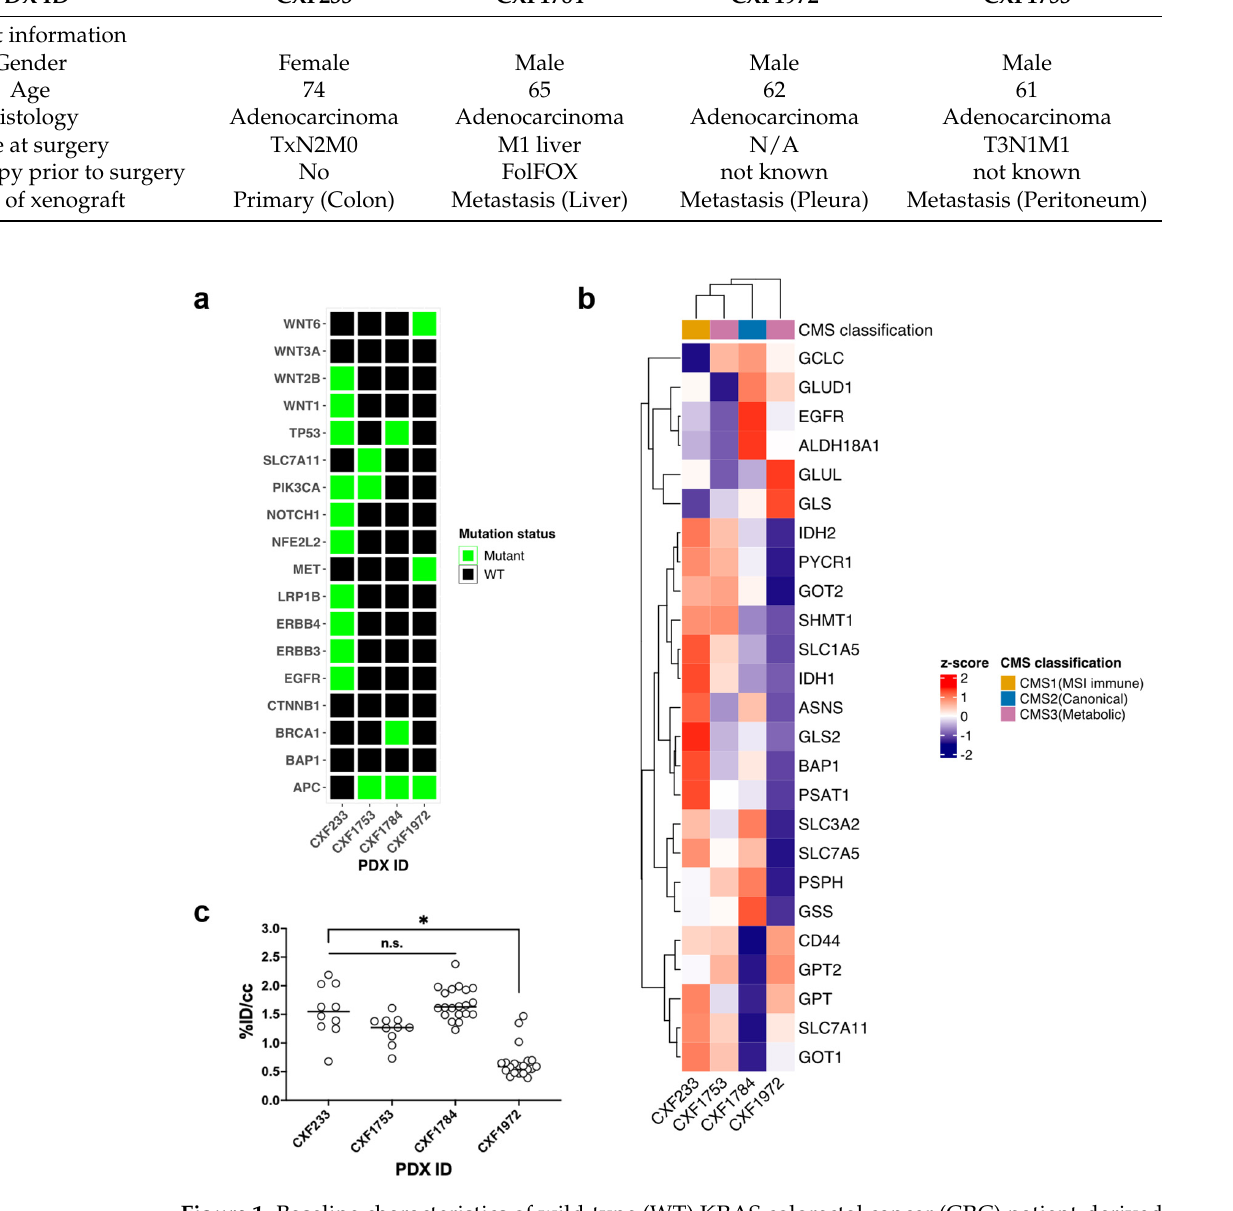
Figure 1. Baseline characteristics of wild-type (WT) KRAS colorectal cancer (CRC) patient-derived xenografts (PDXs). ( a ) Select mutational status highlighted in green for each PDX. ( b ) Transcriptomic profile with glutaminolysis-related genes. The consensus molecular subtype (CMS) was identified based on gene expressions of CRC. ( c ) Baseline (4S) − 4 − (3 − [ 18 F]fluoro − propyl) − l − glutamate